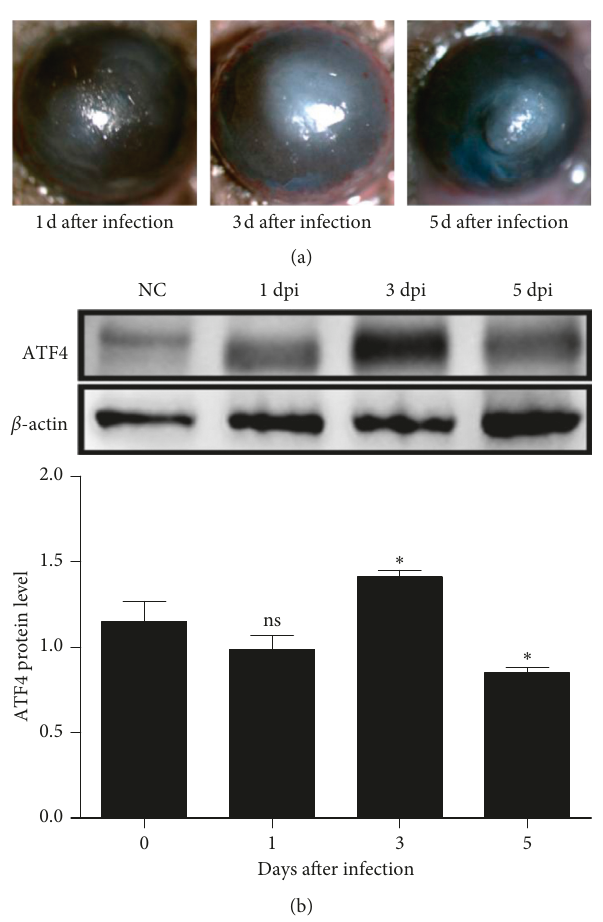
Figure 2: ATF4 was increased in mice corneas of A. fumigatus keratitis developed by corneal epithelium scratch. (a) The signif- icant corneal opacity of C57BL/6 mice models was developed by corneal epithelium scratch formed at 1 day after infection, which persisted up to 5 days. (b) After A. fumigatus infection, ATF4 protein expression was confirmed by western blot to be elevated in infected mouse corneas at 3 days after infection and completely degraded at 5 days. Mean values and standard deviations of two independent experiments are shown; ∗ P < 0 .